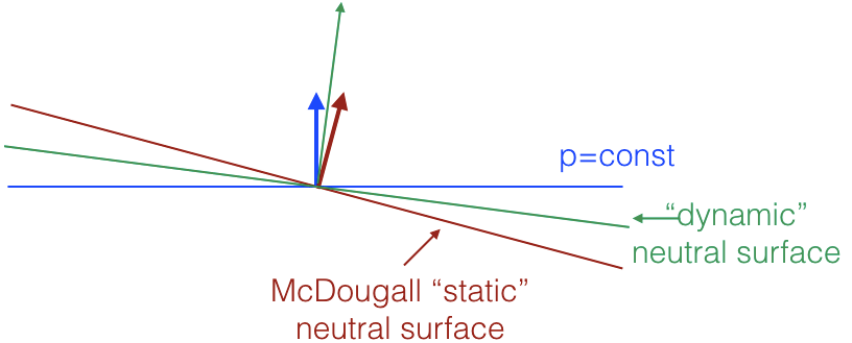
Figure 2. Relative positions of isobaric surface (blue), McDougall neutral surface (red), and "dynamic" neutral surface